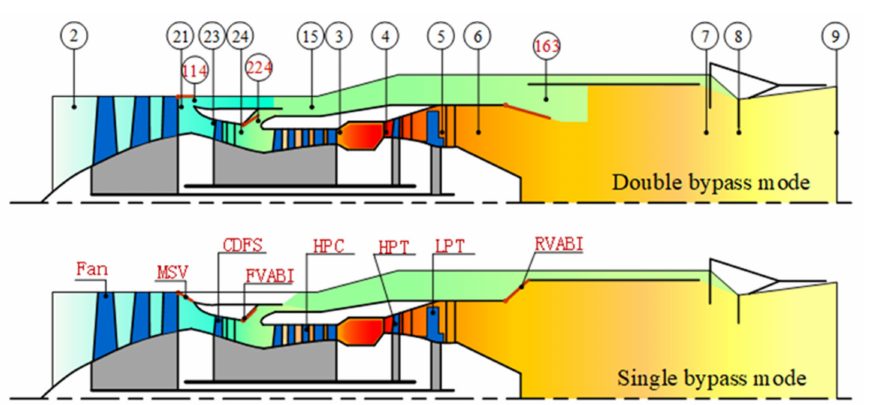
Figure 1. Structure diagram of the variable cycle